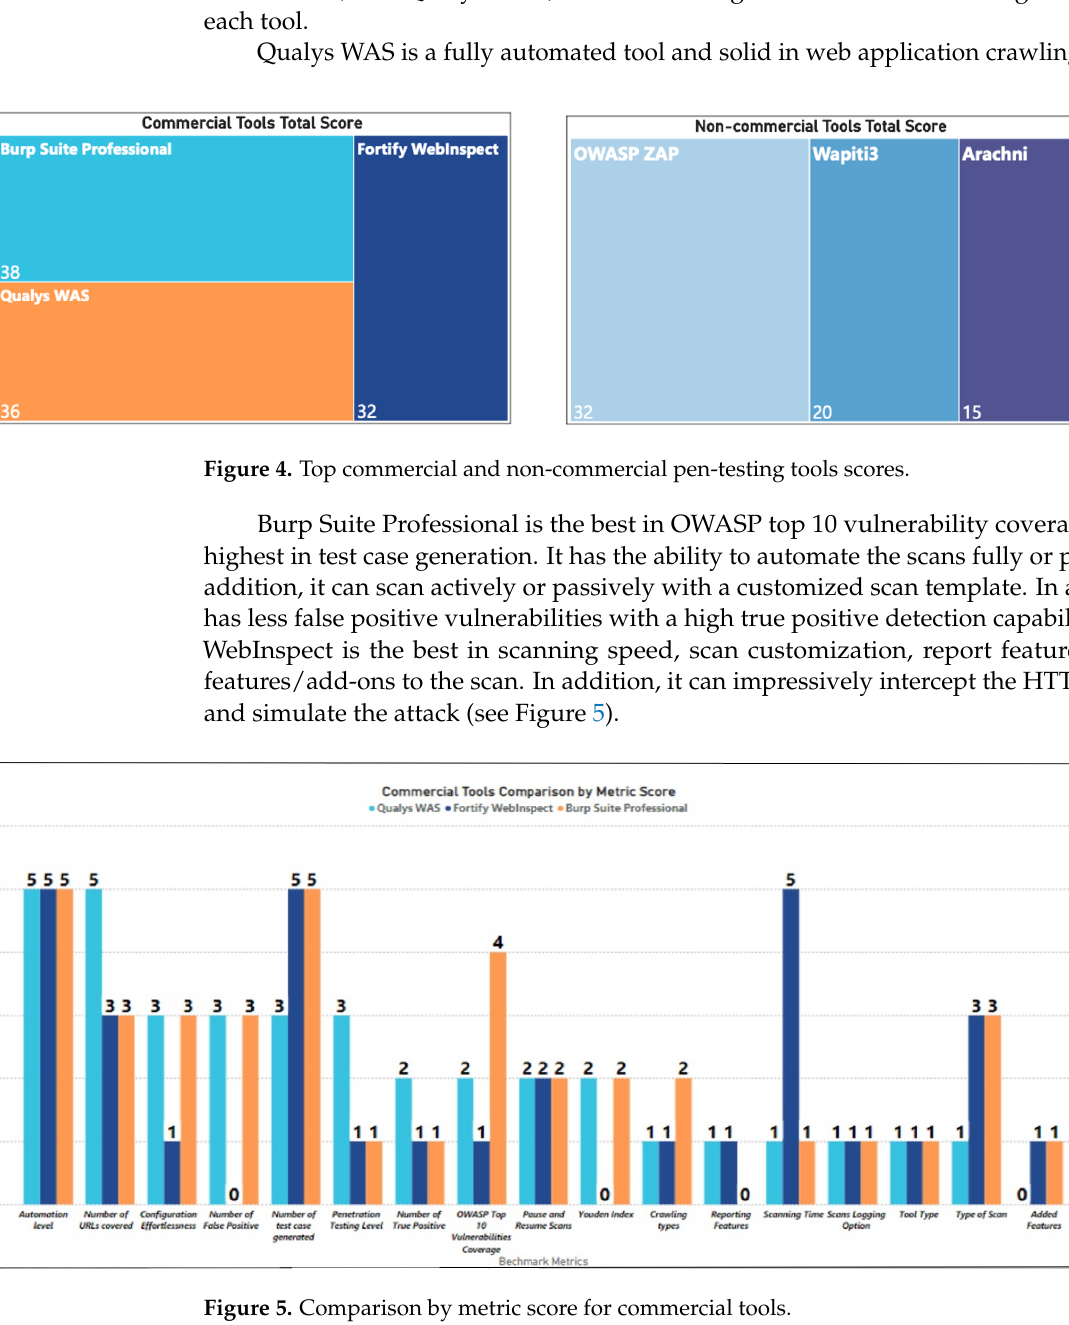
Figure 5. Comparison by metric score for commercial